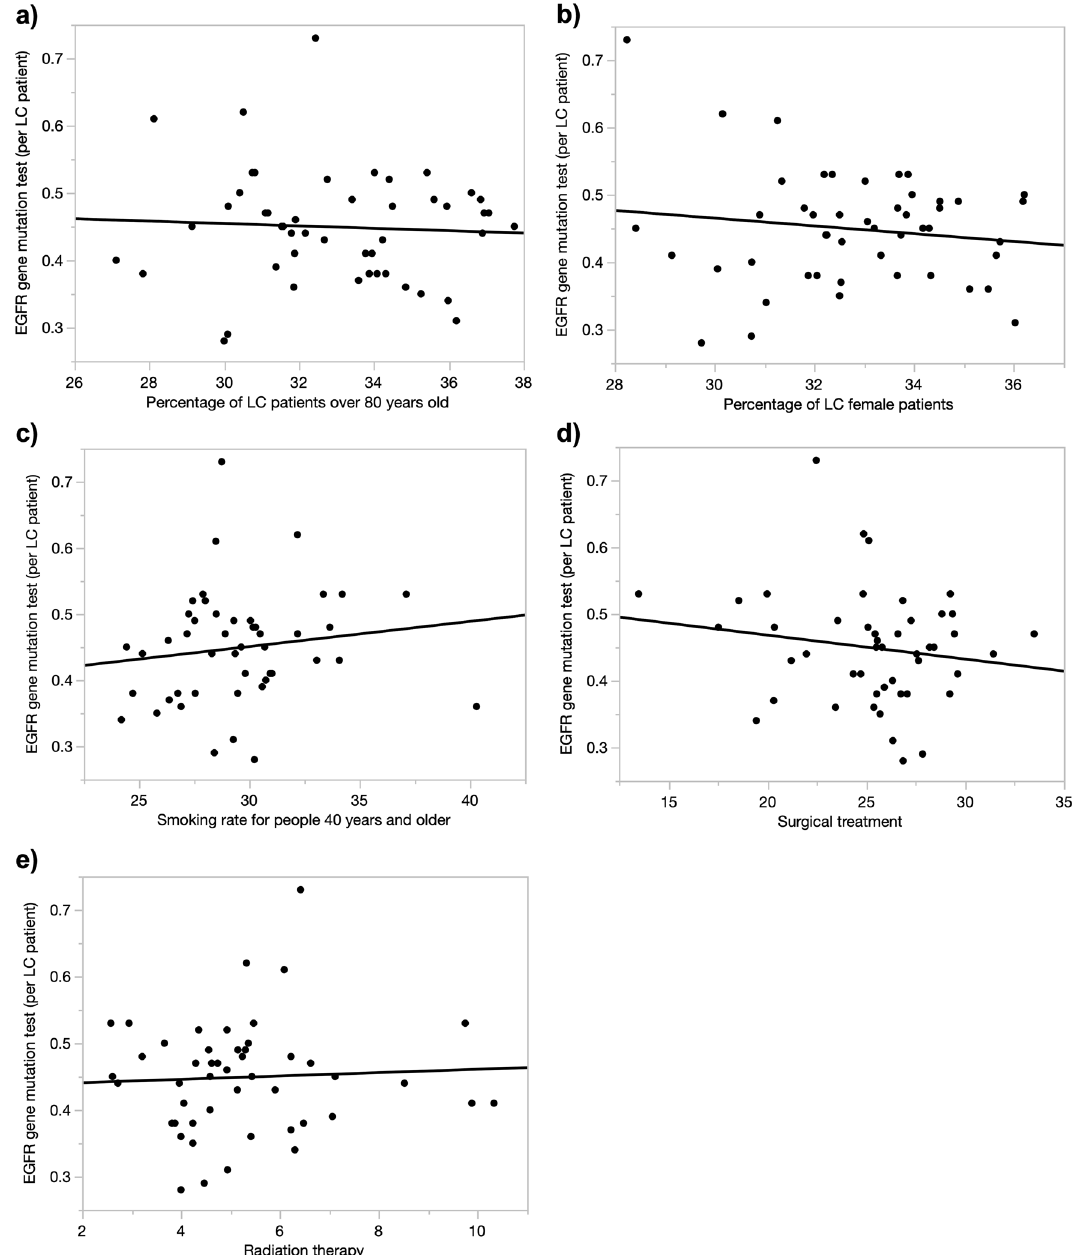
Figure 3. Scatter plots with the value of each explanatory variable on the x-axis and the number of EGFR gene tests performed per lung cancer patient on the y-axis. ( a ) The explanatory variable is the percentage of LC patients over 80 years old. y = 75.3 + 102.9x, R 2 = 0.0031. ( b ) The explanatory variable is the percentage of LC female patients. y = 0.64 − 0.0058x, R 2 = 0.019. ( c ) The explanatory variable is the smoking rate for people 40 years and older. y = 0.34 − 0.0038x, R 2 = 0.020. ( d ) The explanatory variable is the percentage of surgical treatment. y = 0.54 + 0.0036x, R 2 = 0.026. ( e ) The explanatory variable is the percentage of radiation therapy. y = 0.44 + 0.0025x, R 2 = 0.0027. R 2 : coefficient of